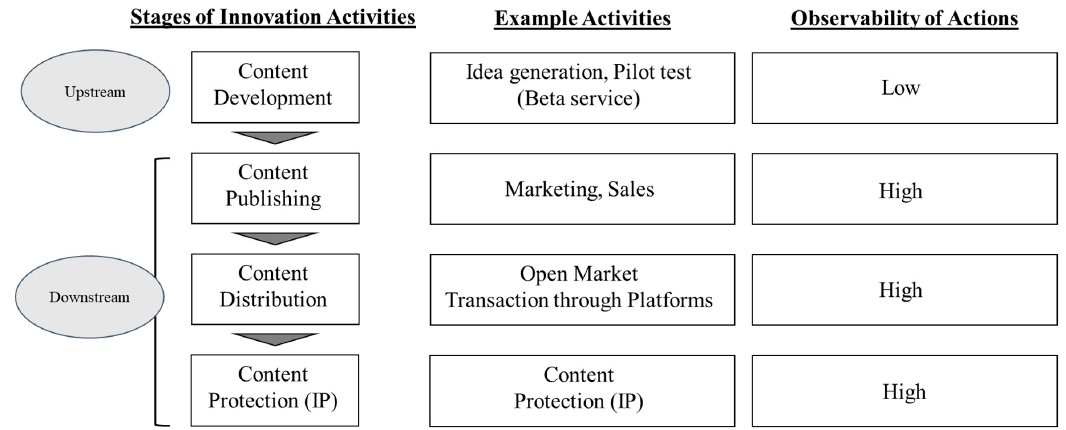
Figure 2. Stages of Innovation Activities in the Mobile Game Industry. Source: Authors’ analysis based on the literature